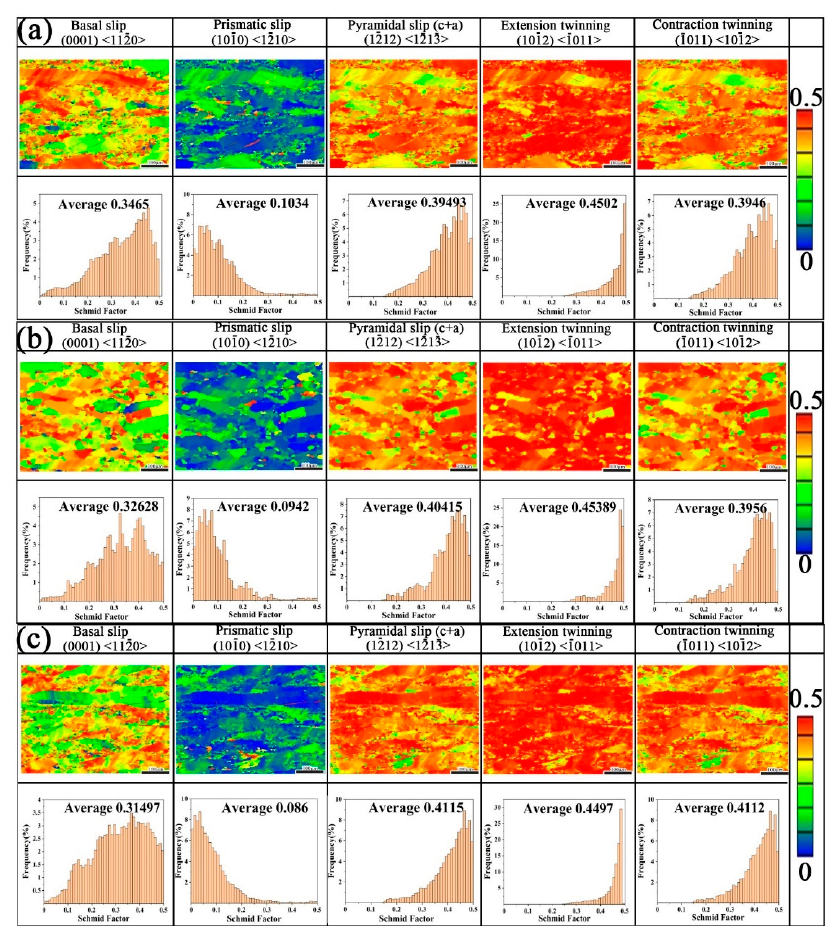
Figure 19. Schmid factor analysis in terms of various deformation mechanisms in Mg-3Bi alloy compressed under different conditions: ( a ) 573 K and 0.01 s − 1 , ( b ) 623 K and 0.01 s − 1 , ( c ) 573 K and 0.1 s − 1 .